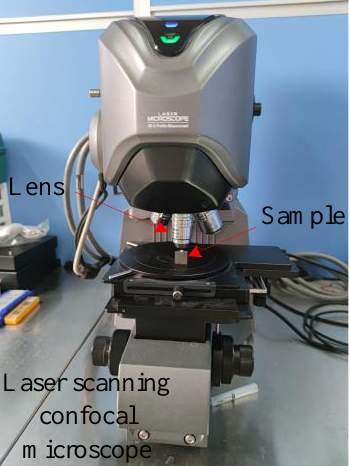
Figure 12. Laser scanning confocal microscope Keyence VK-X250.